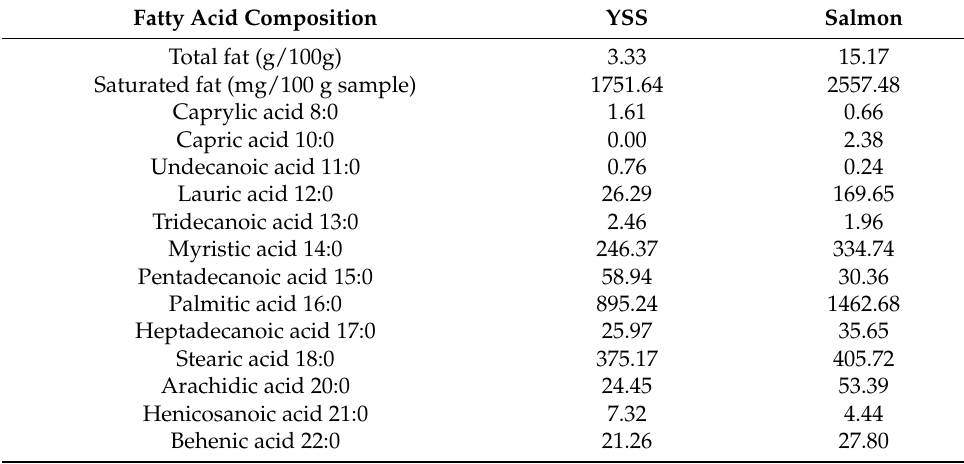
Table 4. Fatty acid composition of fish.